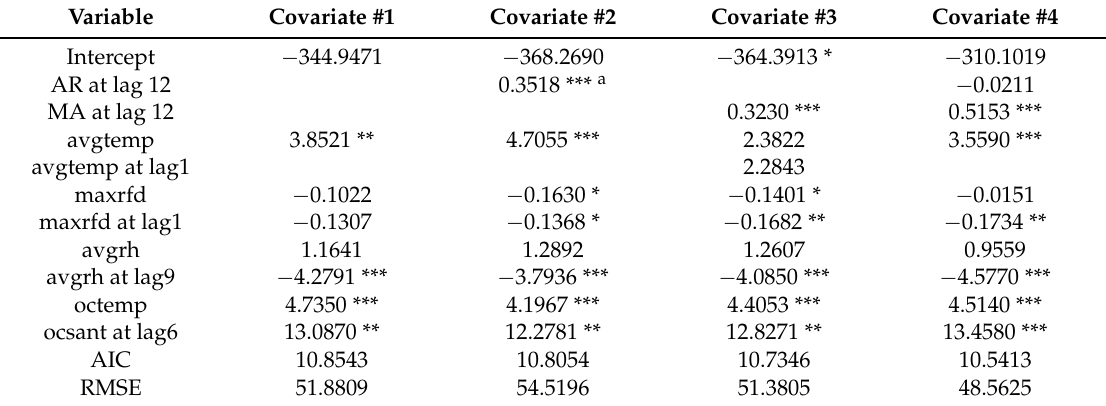
Table 6. The estimation results of ARIMA(1,0,1) 12 for Vibrio parahaemolyticus outbreak series with climatic variables: Covariate